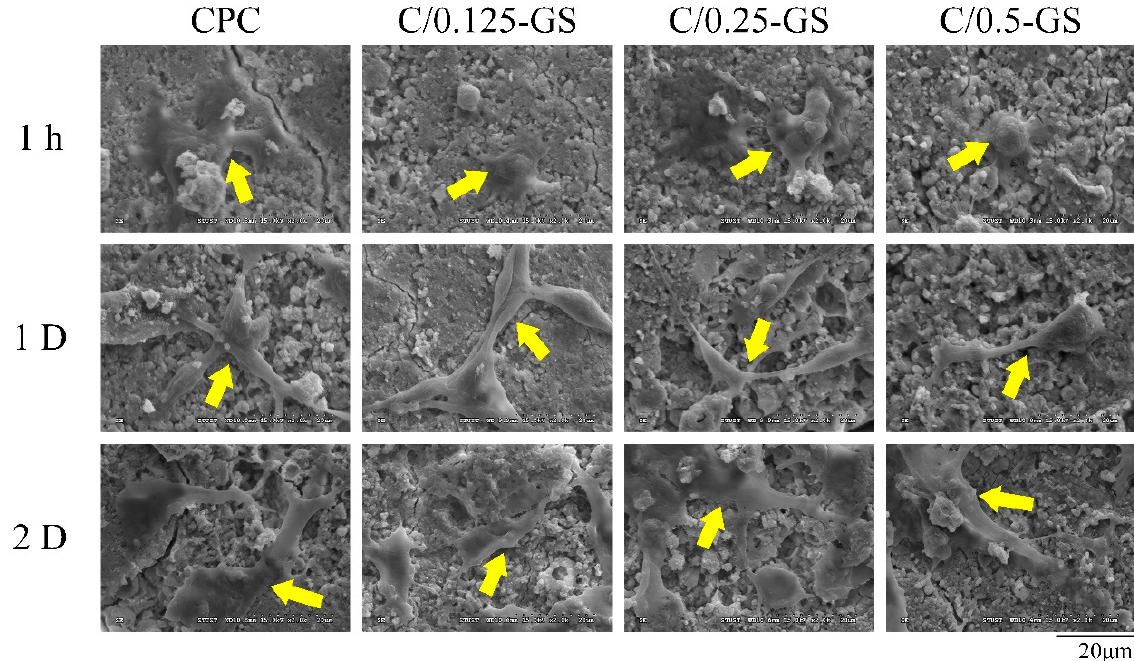
Figure 10. SEM images of cell attachment on CPC/hydrogel composites in contact with D1 cells for 1 h, 1 day, and 2 days.